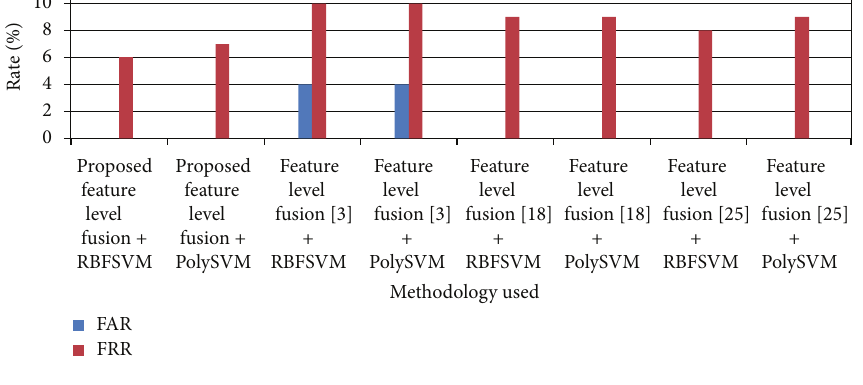
Figure 7: Comparison of error